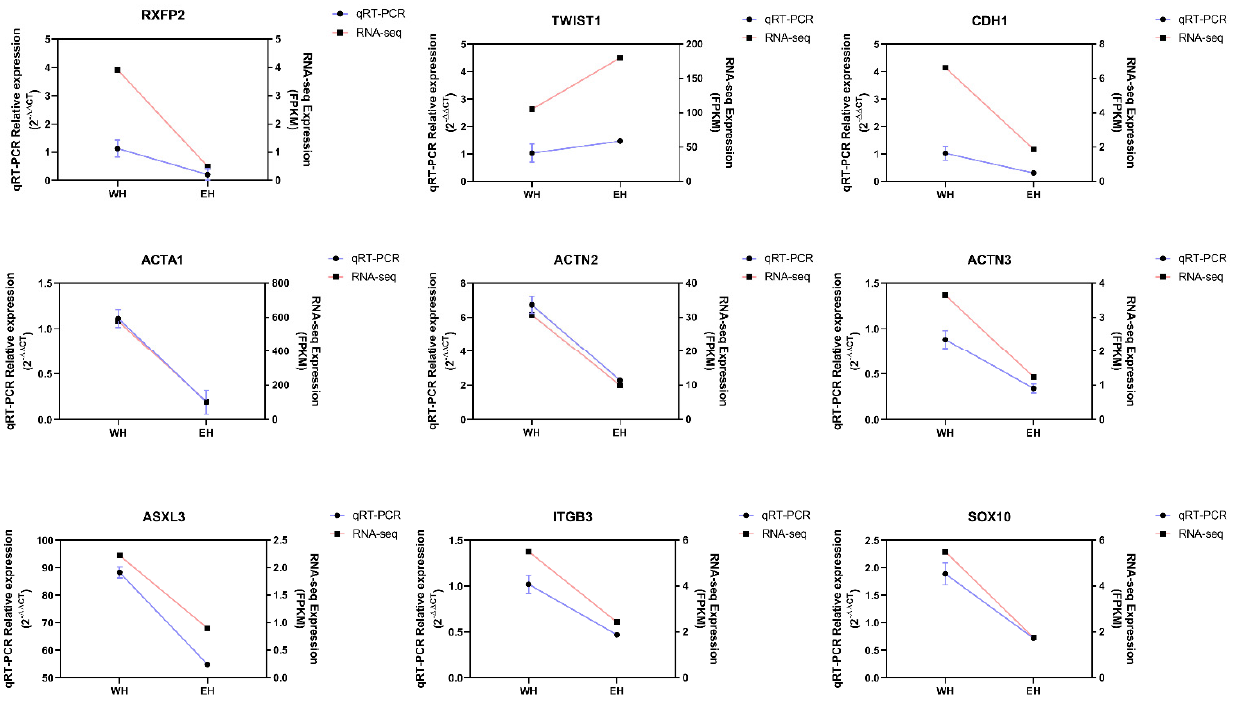
Figure 8. RT ‐ qPCR validation for genes expression. The red line in the graph shows the results of RT ‐ qPCR, the blue line is the result of RNA ‐ seq.